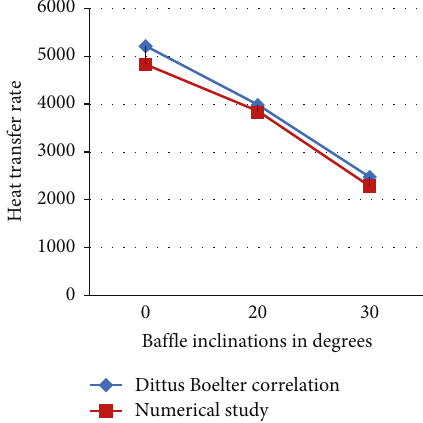
Figure 5: Validation plot of Dittus – Boelter correlation with numerical